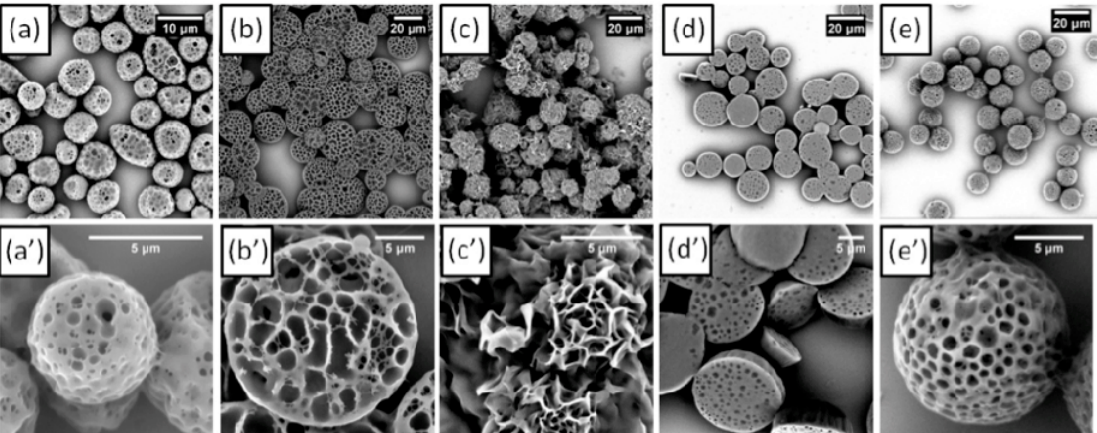
Figure 7. SEM images of PCL-dichloromethane (DCM) microparticles (MPs) collected in the different organic solvents (non-solvents): ( a ) methanol; ( b ) ethanol; ( c ) 1,2-propanediol; ( d ) n-butanol; ( e ) tetraethyl orthosilicate. ( a ′ – e ′ ) High-magnification images showing the surface detail of the same porous MPs from ( a – e ), respectively (reprinted with permission from [152]).